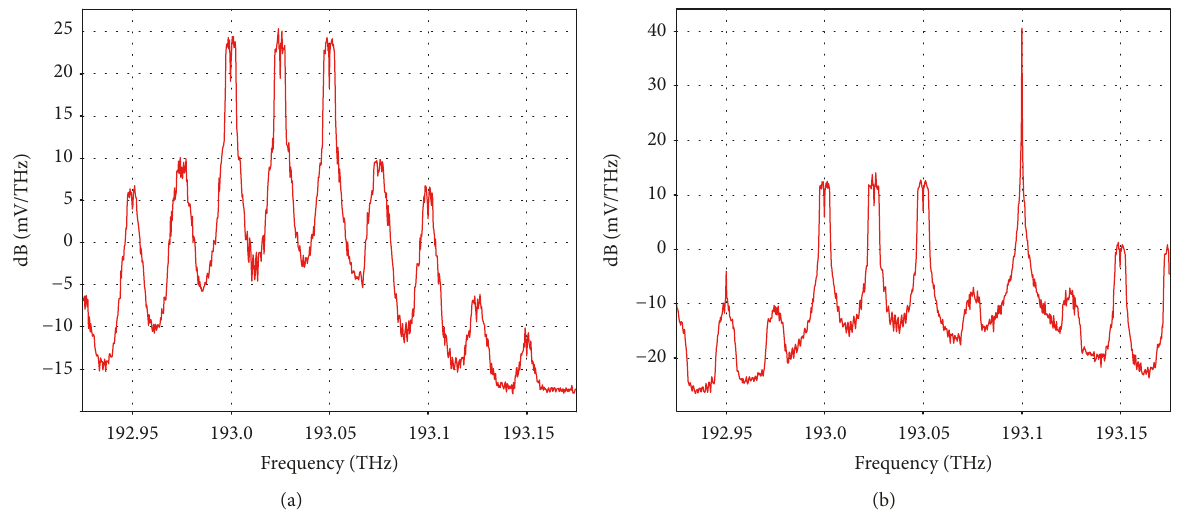
Figure 3: Received optical spectra of OFDM-WDM system (a) without injection-locking and (b) with injection-locking.